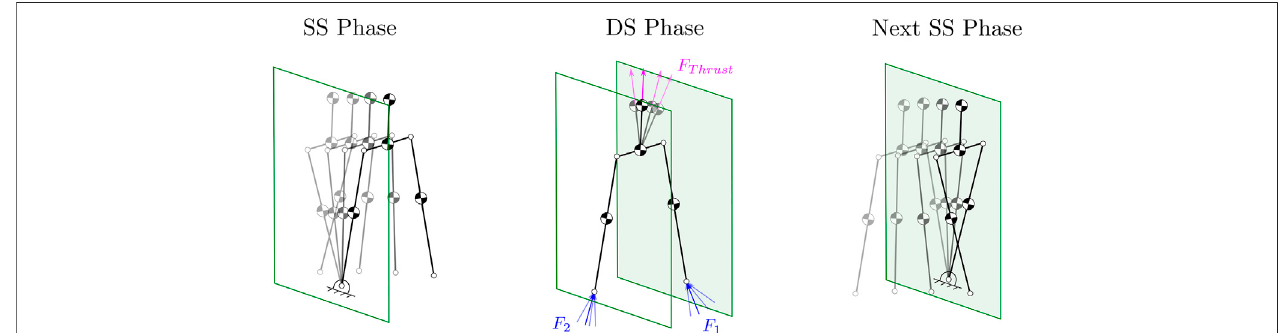
FIGURE 3 | Illustration of the SS and DS phases. Also, shows the thrusters utilized to regulate the GRF.